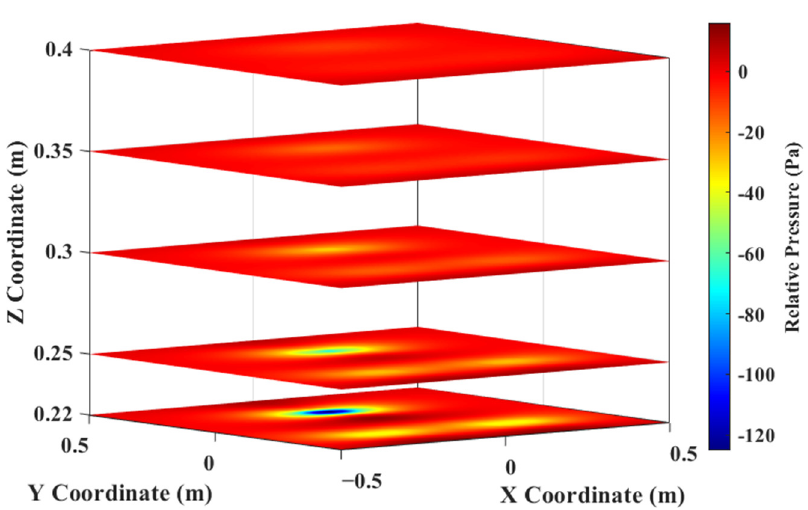
Figure 13. Velocity nephograms of reconstruction with boundary condition of 90°, 15 m/s.